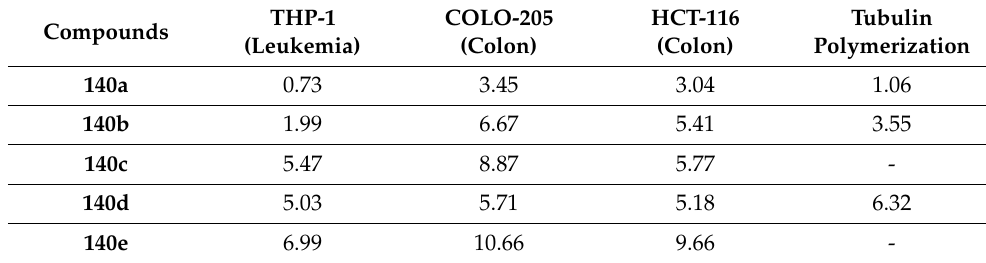
Figure 38. Chemical structures inhibitory values of triazole tethered isatin–coumarin bifunctional hybrids exhibiting anti-cancer and anti-cancer properties. Table 8. IC50 ( µ M) values of active hybrids against sensitive human cancer cell lines and tubulin